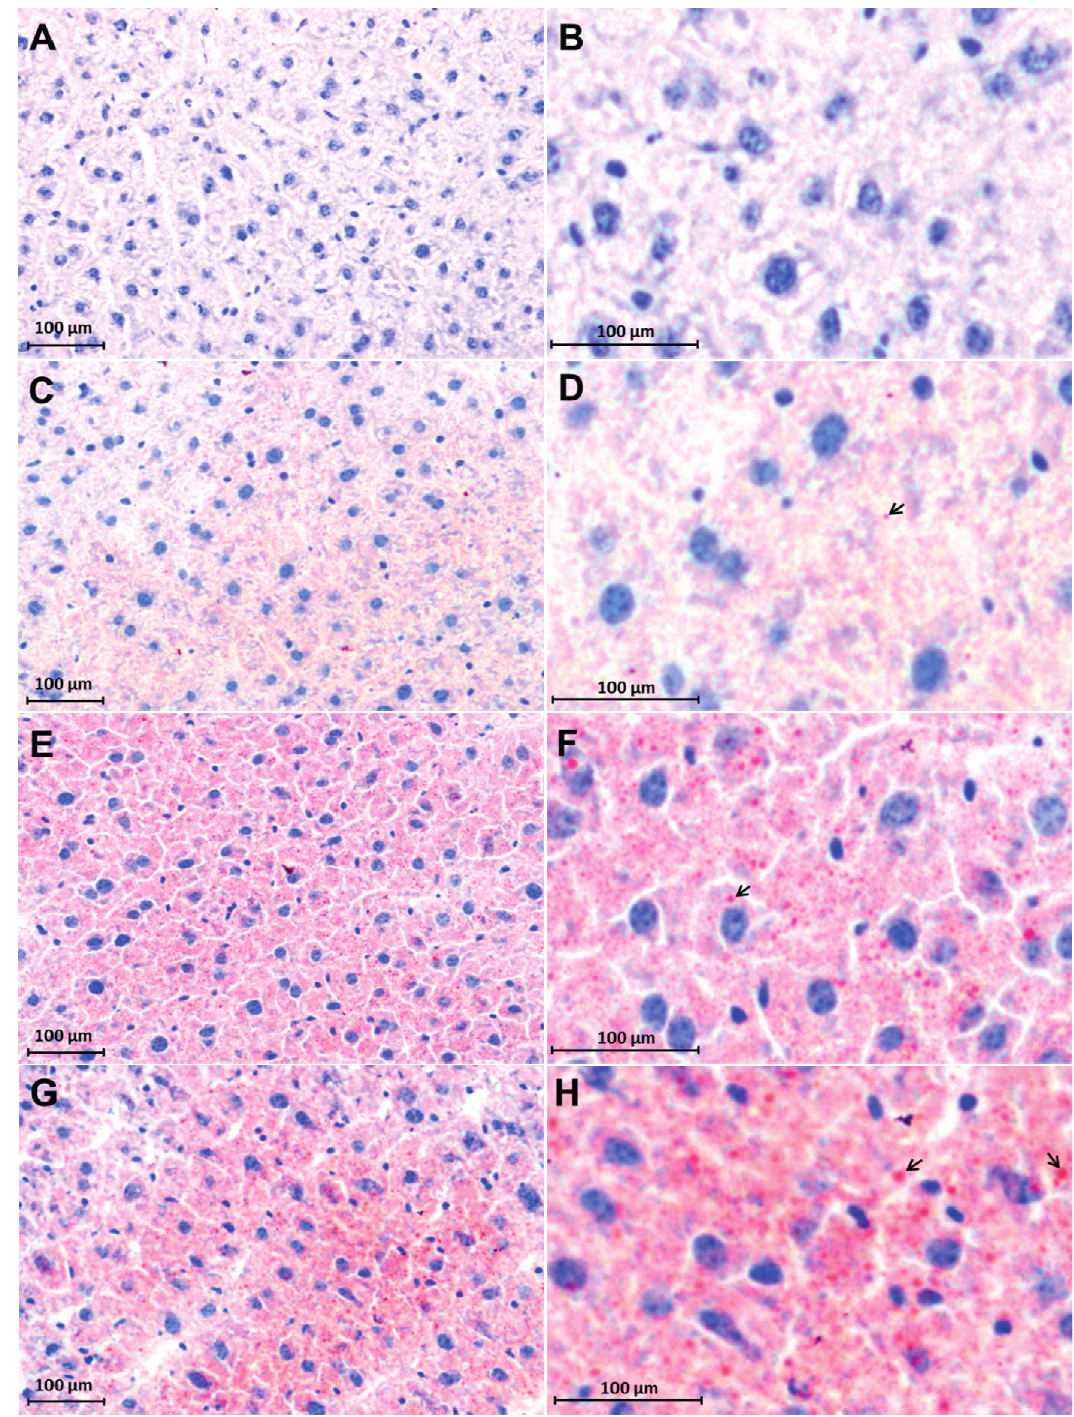
Figure 3. Accumulation of intracellular fat visualized with Sudan III staining in cryosections of livers of sham-irradiated control and irradiated mice. Negative control ( A , B ); Sham-irradiated controls ( C , D ); 6 h post-RT ( E , F ) and 12 h post-RT ( G , H ). The intracellular accumulation of fat droplets (red color) increased with the time after irradiation. ( B , D , F and H ) are magnified areas of ( A , C , E and G ); The arrows in pictures ( D , F and H ) show intracellular lipid droplets. Nuclei are stained blue. Results are representative photographs of three animals and six slides per time point (original magnification,